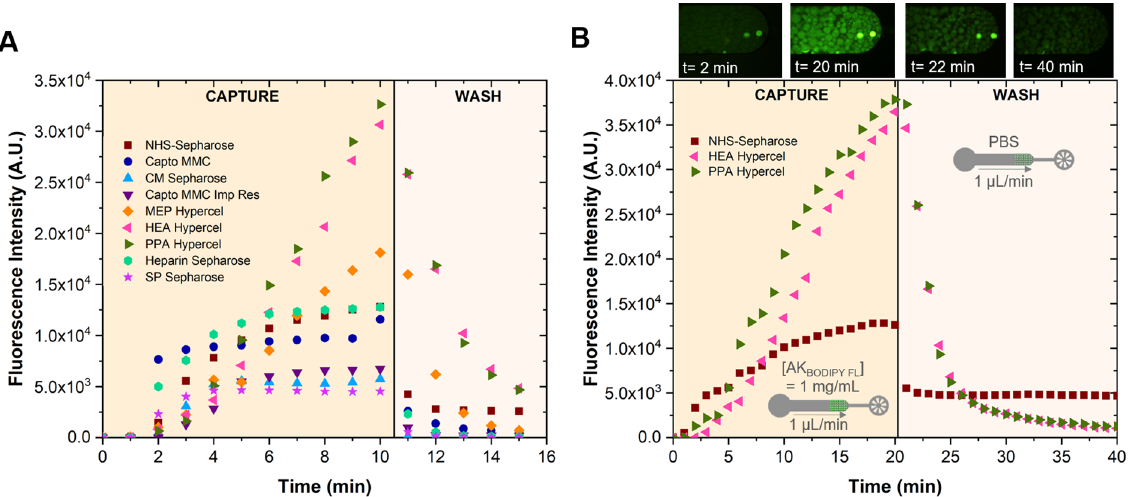
Figure 4. Microbead screening study: ( A ) test of different microbeads to determine the optimal microbead to capture adenylate kinase (AK). A solution of AK BODIPY FL = 1 mg/mL was set to flow through the beads for 10 min and a washing step with PBS 1x was performed for 5 min (n = 1); ( B ) capture and longer washing curves obtained by continuously measuring the fluorescence intensity of the packed NHS Sepharose, HEA Hypercel, and PPA Hypercel beads (n = 1). The images refer to NHS Sepharose. The excitation wavelength was 450–490 nm (blue).